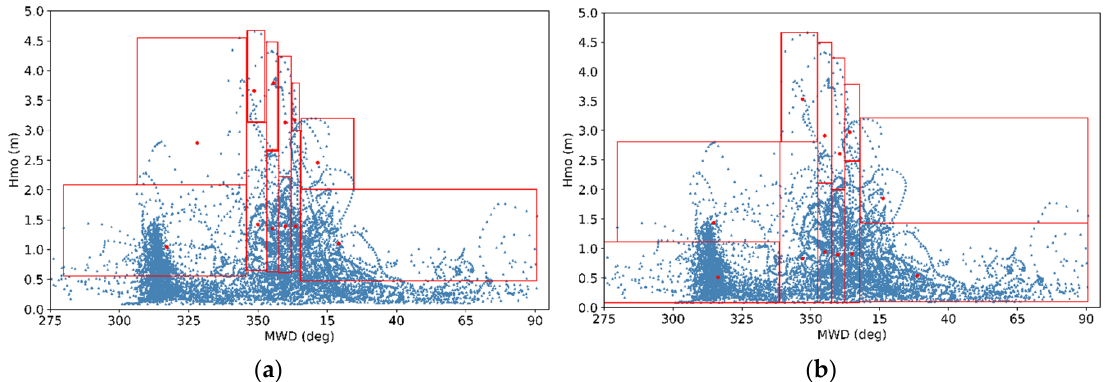
Figure 6. Scatter plot showing the full dataset of a year of data (blue markers) along with the bins (red rectangles) and representative wave conditions (red markers) using the pick-up rate method ( a ) and the energy-flux method ( b ).